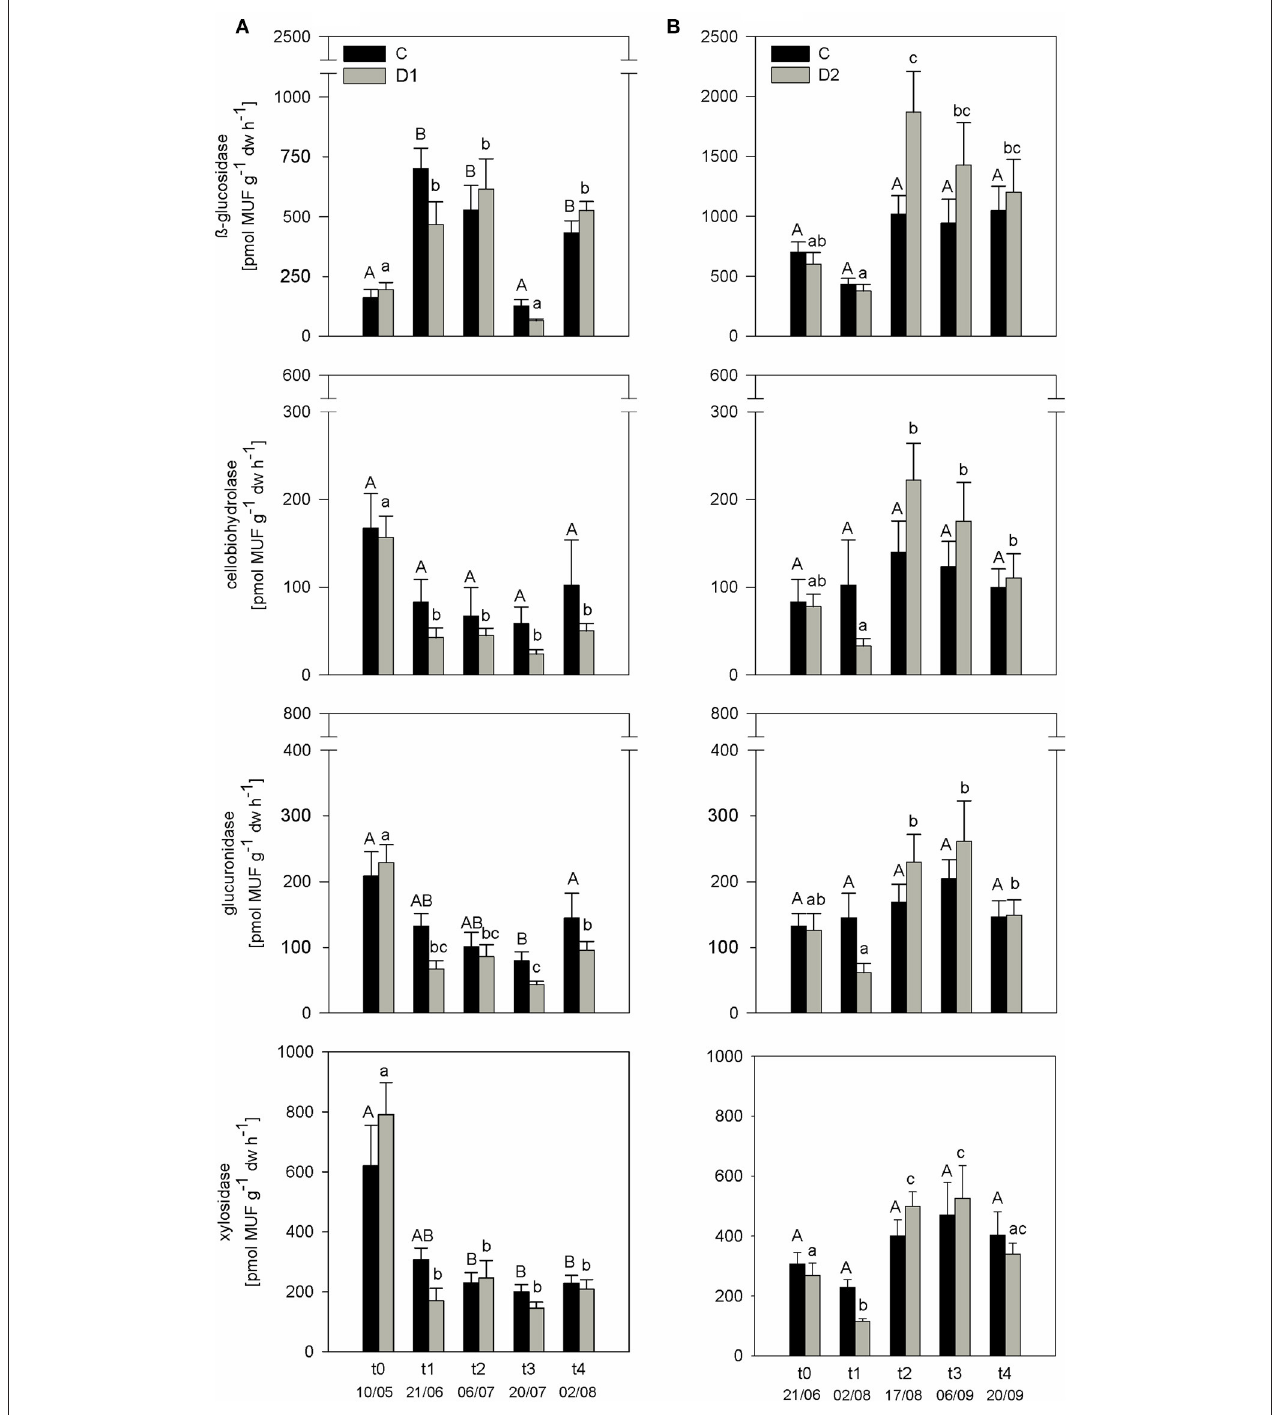
FIGURE 2 | Potential extracellular enzyme activities (PEEA) [pmol MUF g − 1 h − 1 ] of 2010 under different precipitation variabilities for control (C, black bars) and drought/rewetted plots (D, gray bars) at (A) spring drought and (B) summer drought simulation; given are mean values and standard error of measuring dates, each n = 5; drought treatment occurred from t0 to t1; significant differences ( p < 0.05) between C and D are marked with asterisks; significant differences ( p < 0.05) among sampling times are indicated by different letters.